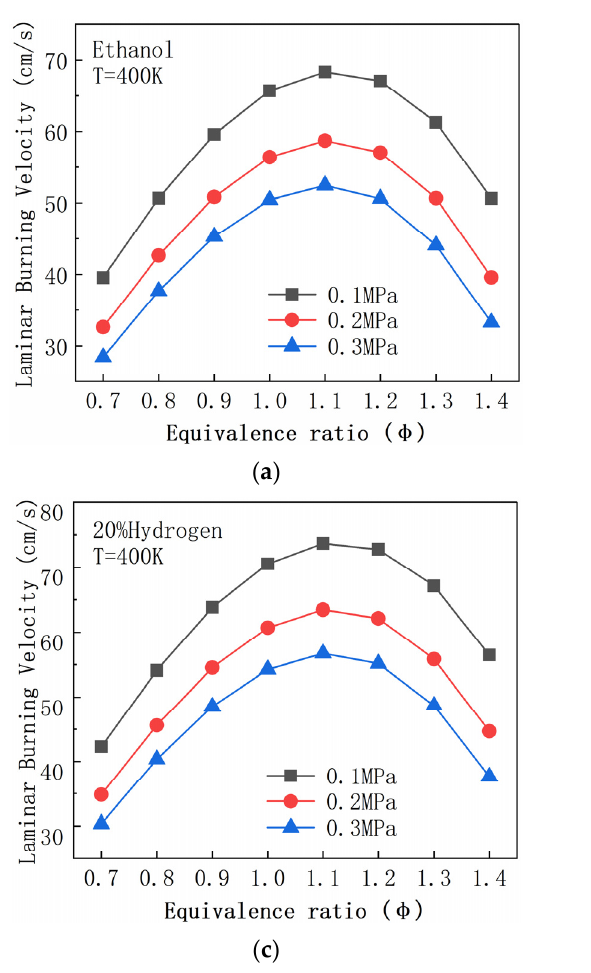
8 of 17 Figure 7. LBVs at different initial temperature and P0 = 0.1 MPa: ( a ) ethanol, ( b ) 10% hydrogen, ( c ) 20% hydrogen, and ( d ) 30% hydrogen. Moreover, the LBVs of fuels with various mixing ratios at different initial pressures and the initial temperature of 400 K are shown in Figure 8. There is a correlation ( 𝑆 (cid:3048)(cid:2868) ∝ 𝑃 (cid:3289) (cid:3118) (cid:2879)(cid:2869) , 𝑛 is the order of reaction) between LBV and pressure [31]. When the initial pressure increased, 𝑃 (cid:3289) (cid:3118) (cid:2879)(cid:2869) decreased; therefore, LBV decreased. The above results show that hydro-